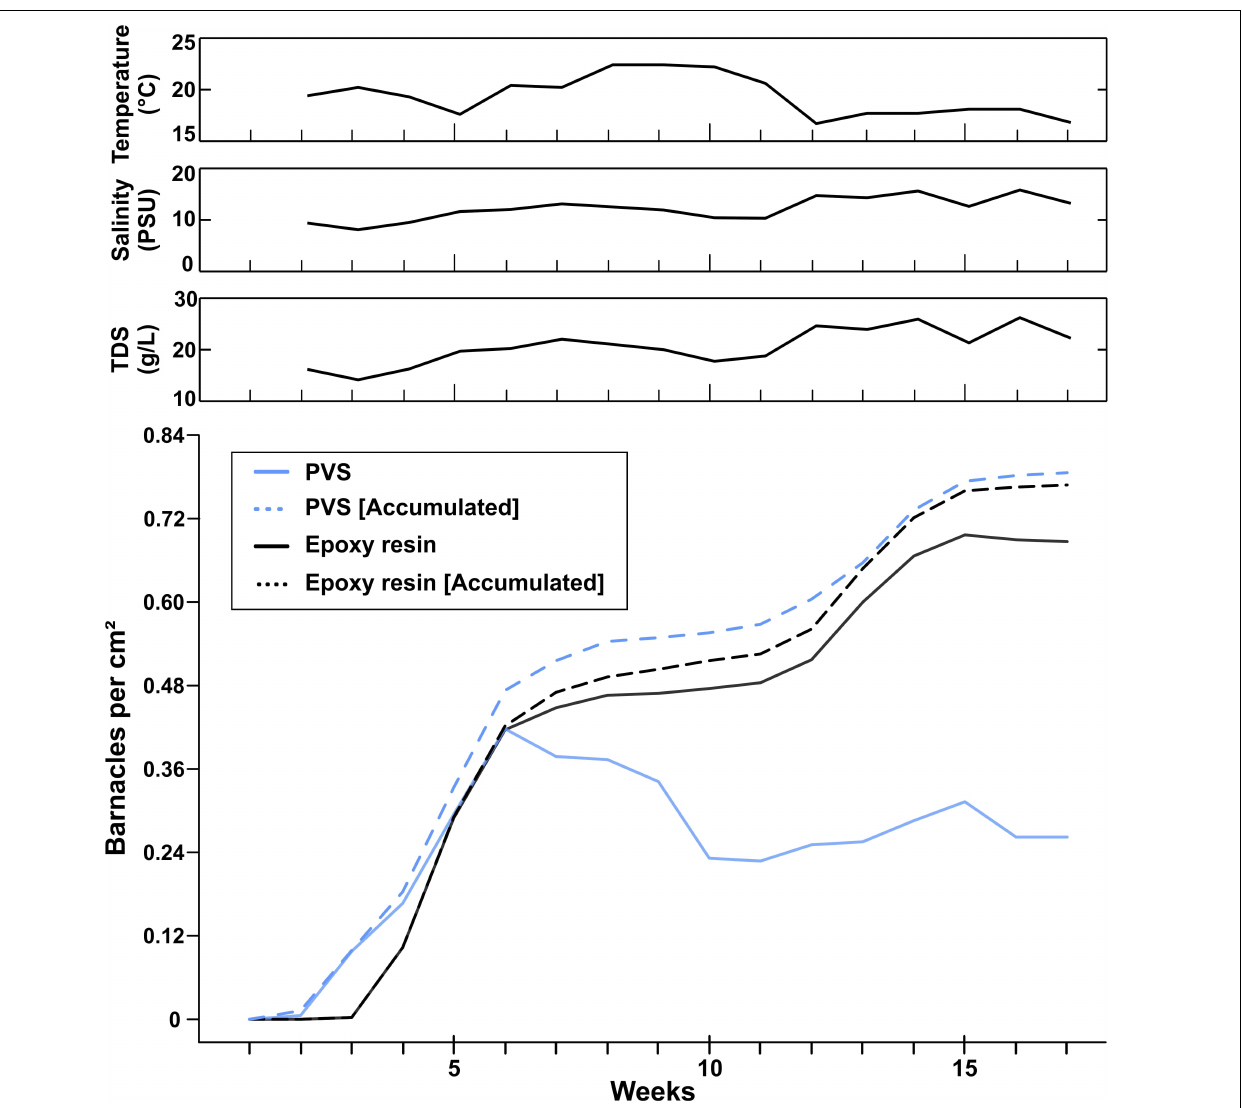
FIGURE 4 | Actual and cumulative barnacle densities (total number of barnacles per cm 2 ) in dependence of the substrate material during the field experiment 1. Abiotic factors were monitored weekly [temperature, salinity, total dissolved solutes (TDS)].